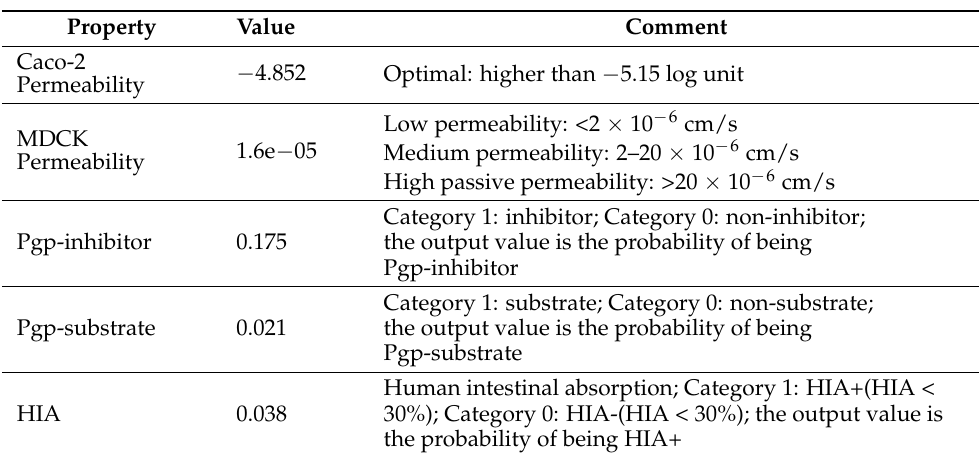
Table 8. The absorption of compound 1